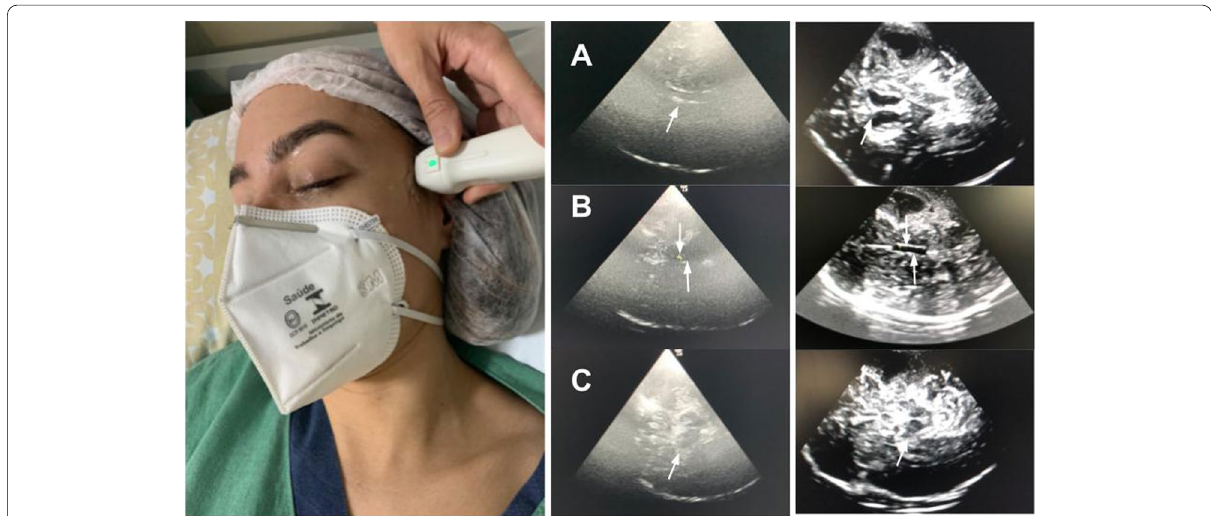
Fig. 3 The transtemporal window approach and the three images of the brain’s ultrasonography planes. A Ventricular plan. B Diencephalic plan. C Mesencephalic